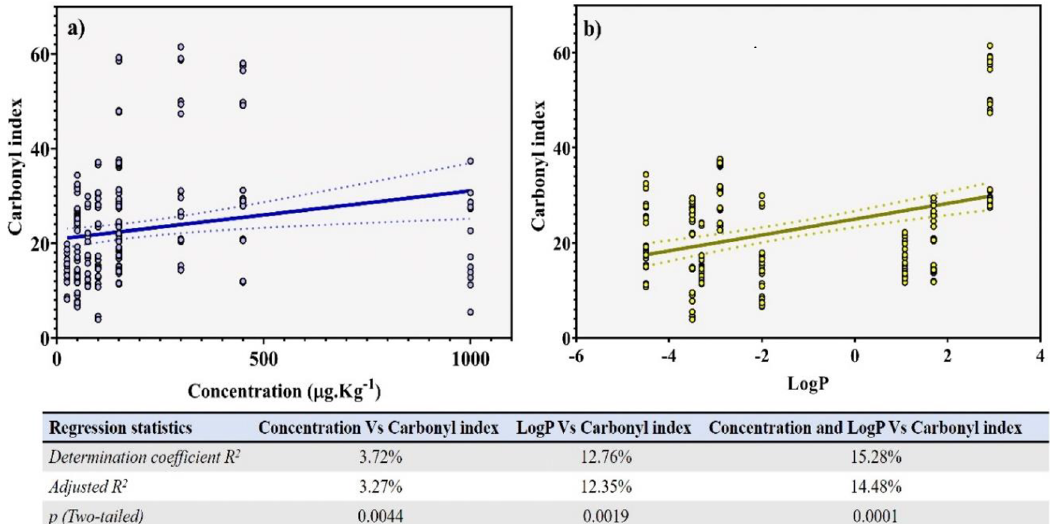
Figure 6. Multiple linear correlation analysis performed between antibiotic-induced carbonylation vs (a) assayed concentration of antibiotics and (b) antibiotics ’ Partition Coefficient (log P). These parameters were used to evaluate the variables ’ relation level were the correlation and determination